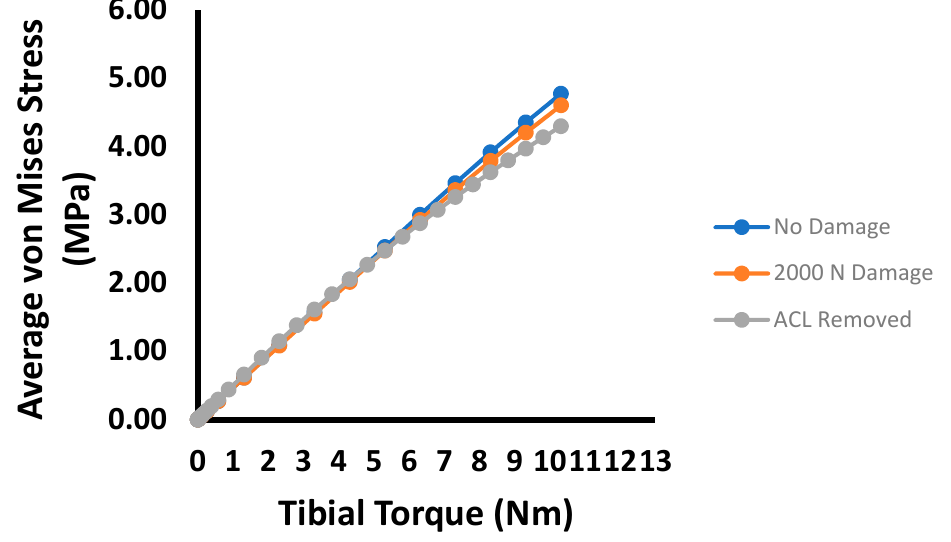
Figure 5. Plot of average MCL mid-substance von Mises stress (MPa) versus internal tibial torque for the three prescribed damage cases.